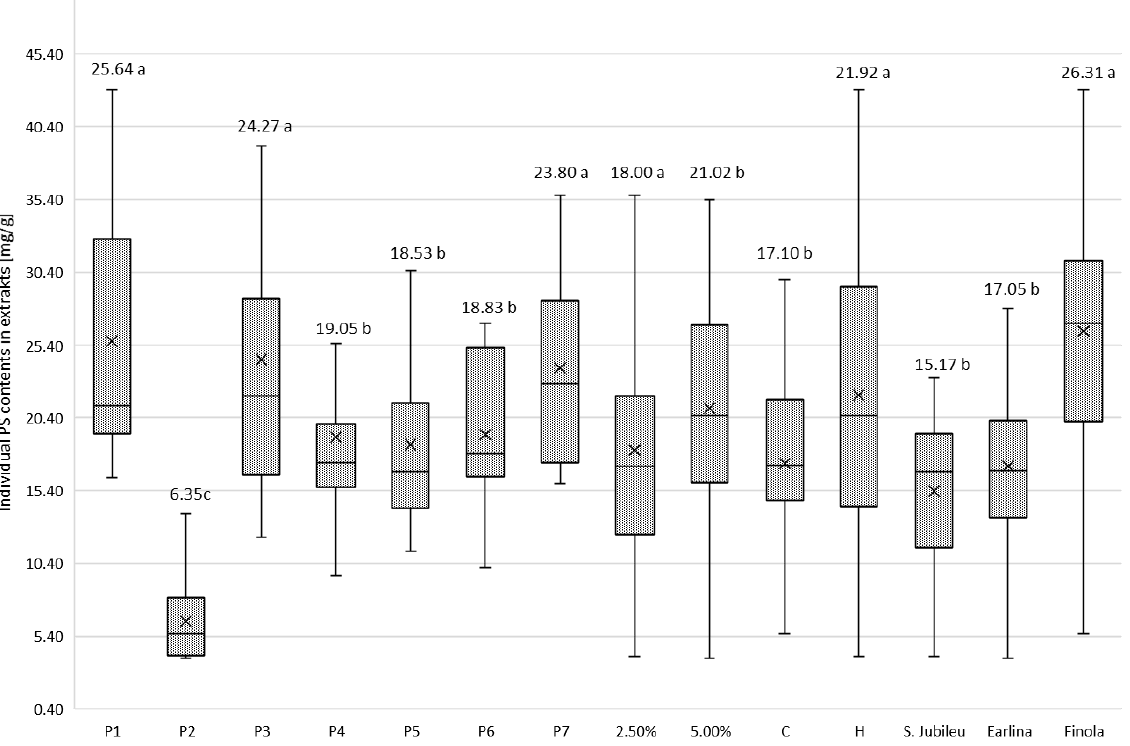
Figure 3. Mean values of phytosterol content (mg/g of dm) in post-bleaching methanolic extracts according to hemp variety, temperature of oil pressing, dose of bleaching earth and type of bleaching earth. a,b,c—homogeneous groups in Duncan’s test ( p < 0.05) determined separately for each independent variable.